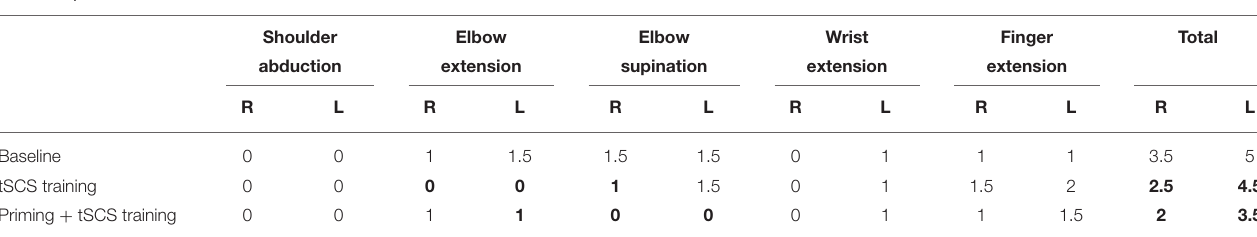
TABLE 2 | Modified Ashworth Scale.